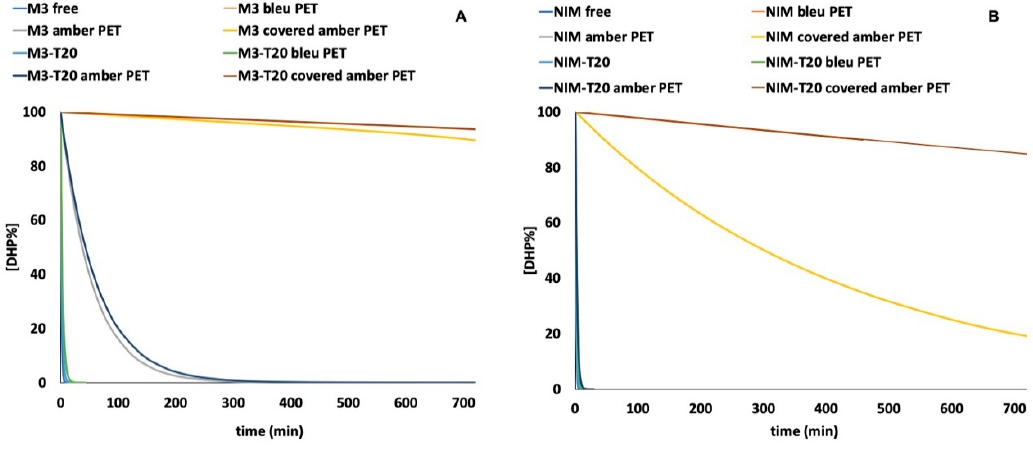
Figure 6. Photodegradation of M3-T20 ( A ) and NIM-T20 ( B ) in different PET containers.